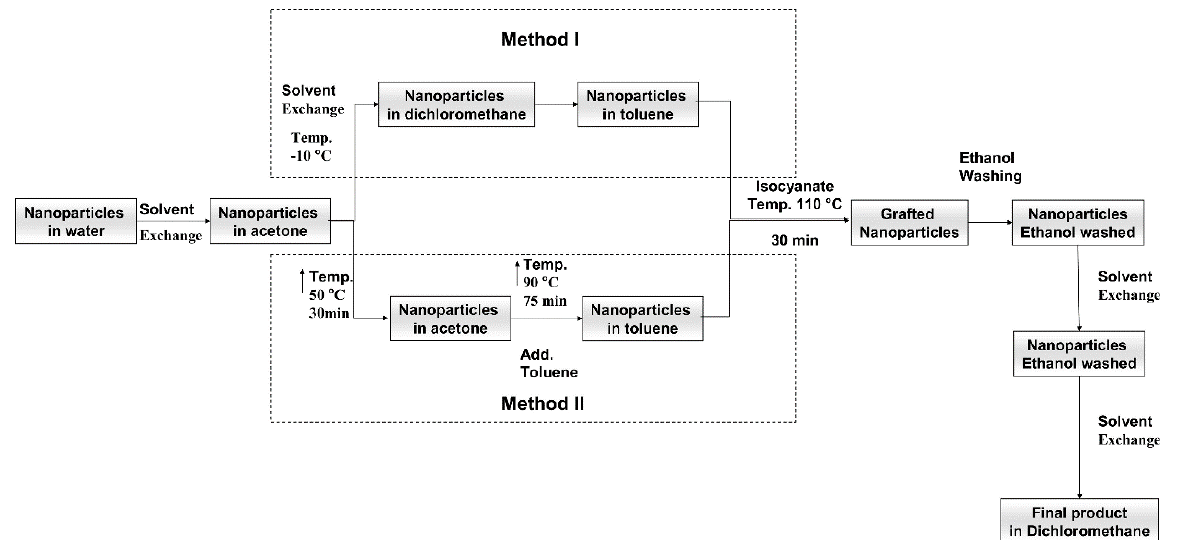
Figure 7: Protocol for the two surface grafting methods. Adapted from [67] copyright 2010 American Chemical